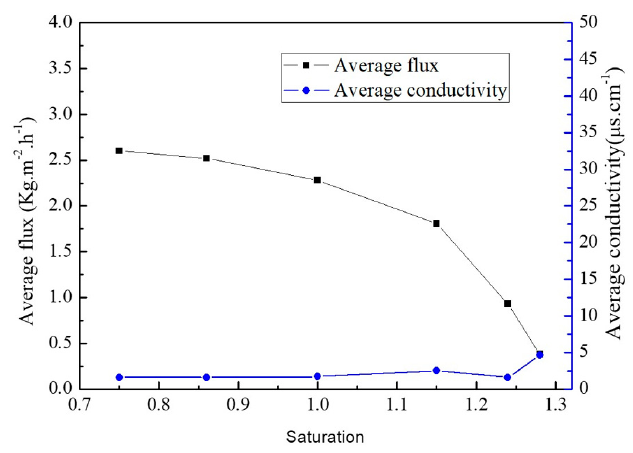
Figure 4. Evolution of flux and water yield conductivity during preferential crystallization of ZnSO 4.